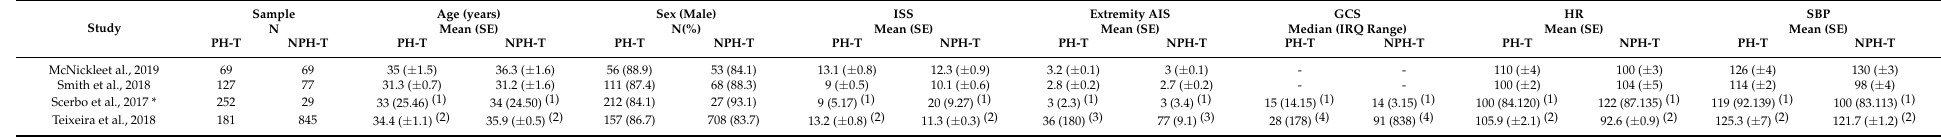
Table 2. Demographic and clinical characteristics of observational studies.